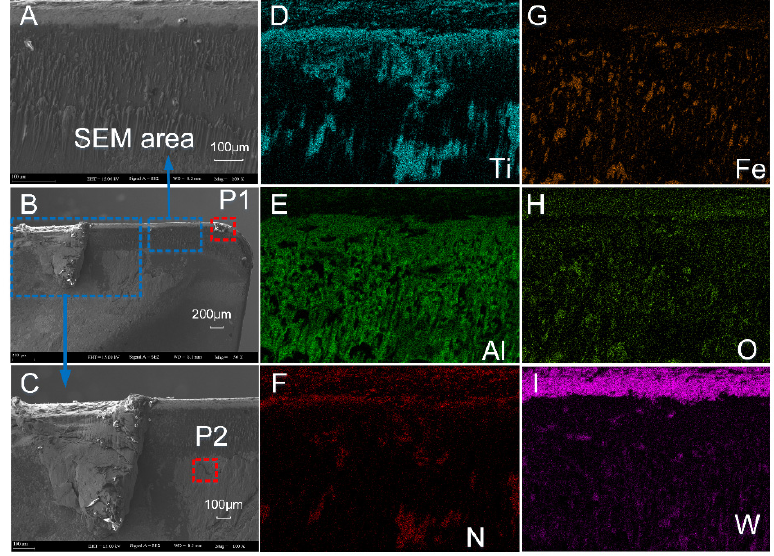
Figure 11. ( A – C ) The rake face wear of Tool A after 70 min of cutting. ( D – I ) Distribution of elements.